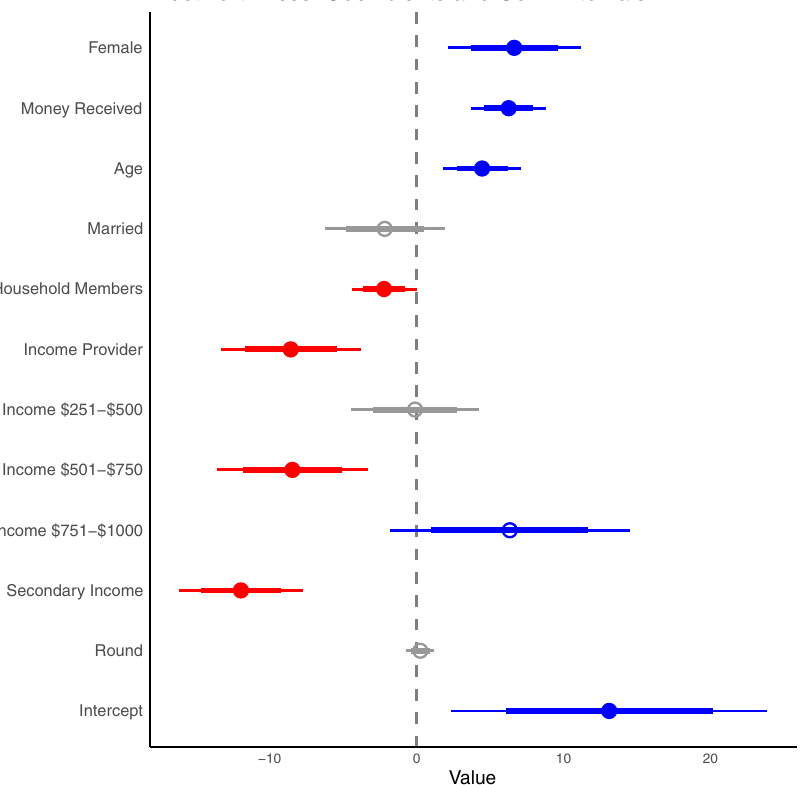
Figure 4. Coefficient plot of how the amount sent by receivers (Trustworthiness) is related to gender, money received (i.e., money sent by senders tripled), age, marital status, number of household members, whether a subject was the income provider, the levels of monthly income (in USD), whether the subject had a secondary non-fishing income, and the round number. Thick lines represent 80% confidence interval, while thin lines are 95% confidence